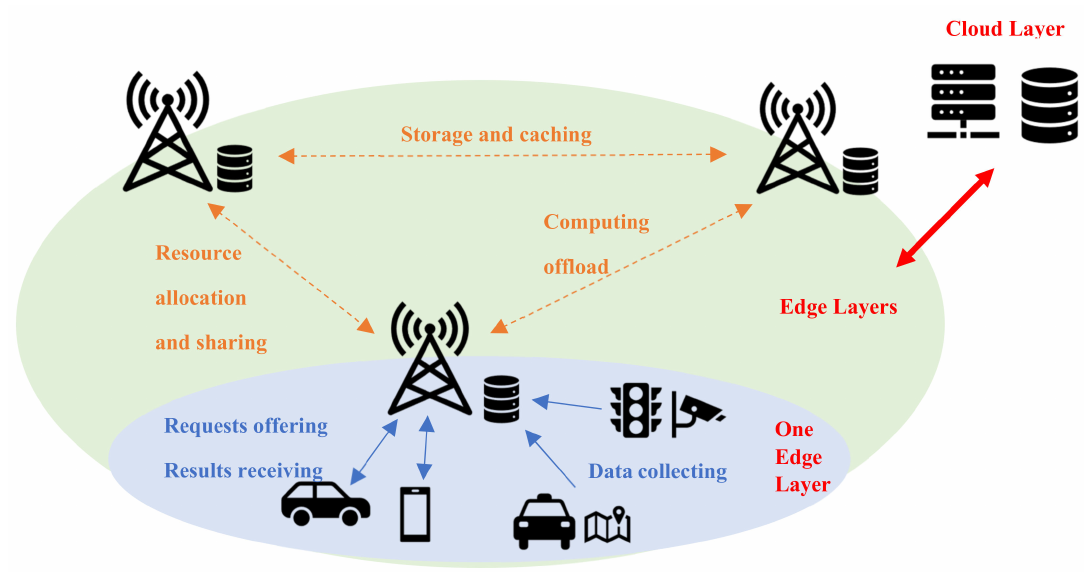
Figure 1. Spatio-temporal data platform.